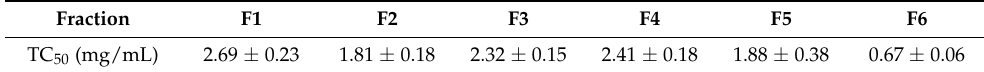
Table 2. Calculated TC 50 concentrations of BLG nanoparticle fraction.